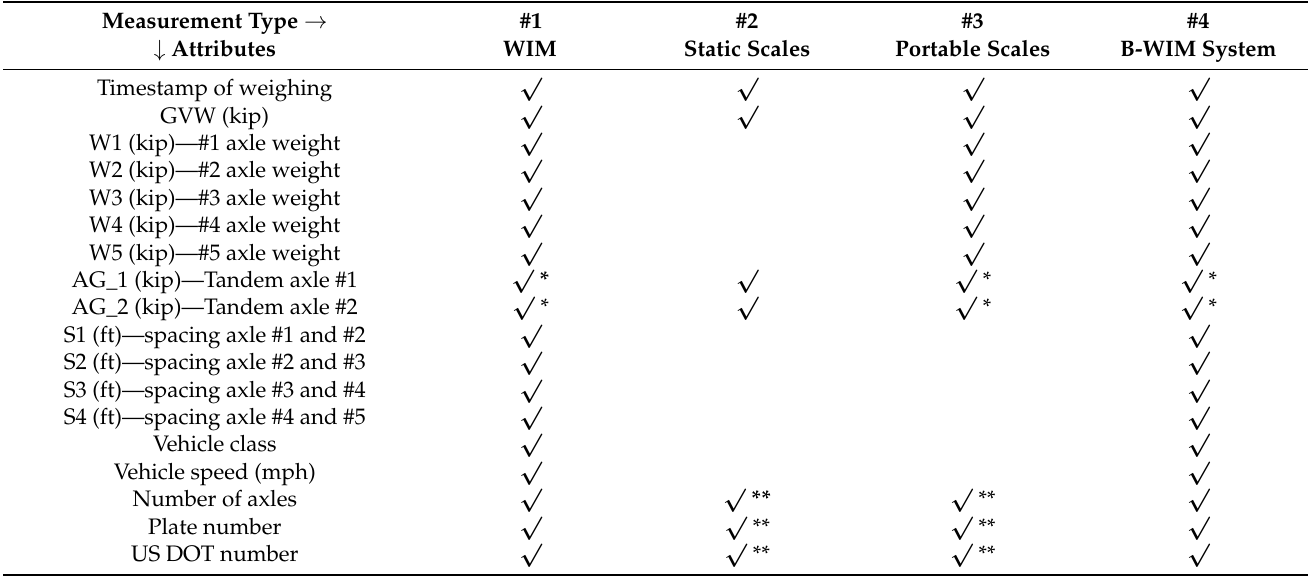
Table 1. Attributes considered during